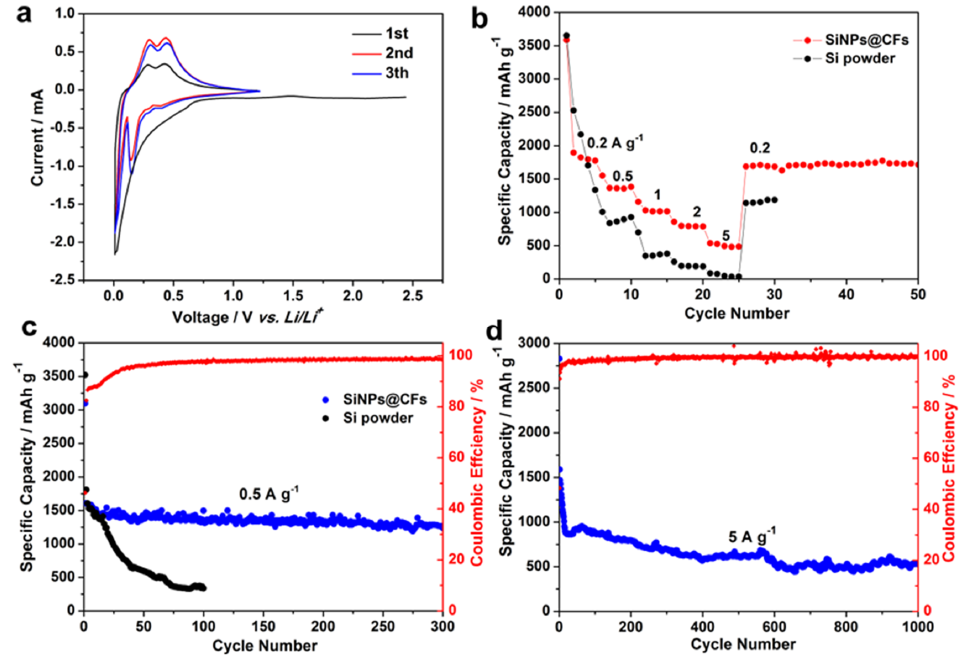
Figure 4. Electrochemical performance of SiNPs@CFs/Li half-cells in the potential range 0.01–1.2 V (vs. Li/Li + ): ( a ) CV curves at a sweep rate of 0.1 mV·s −1 ; ( b ) rate performance (0.2–5 A·g −1 ) of SiNPs@CFs and pure Si powder; ( c ) cycling performance of SiNPs@CFs and pure Si powder at 0.5 A·g −1 ; ( d ) cycling performance of SiNPs@CFs at 5 A·g −1 .